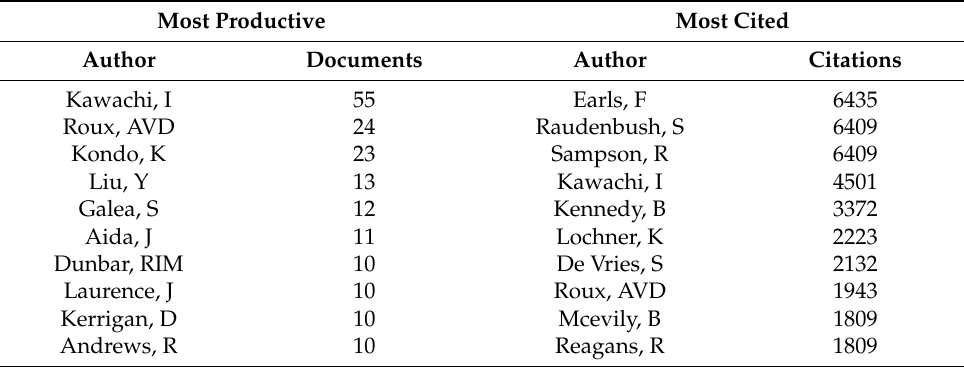
Table 5. Top 10 most productive and most cited authors on “social cohesion.”